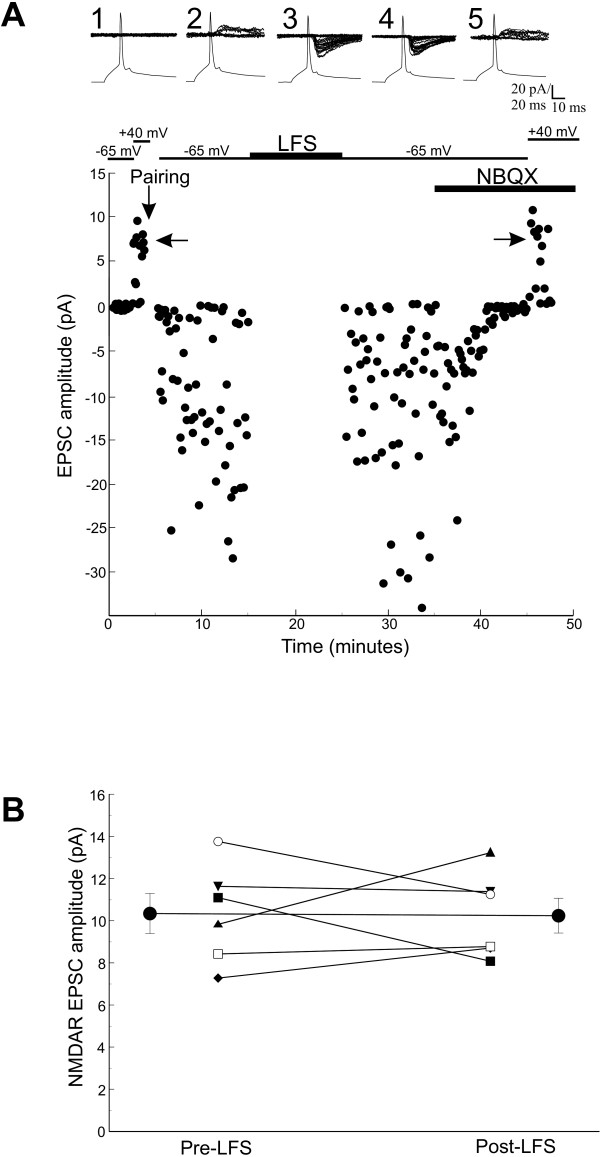
NMDAR-mediated responses are not depressed by LFS in recently unsilenced synapses. A. An individual experiment showing a silent synaptic connection with no AMPAR-mediated transmission at -65 mV. Depolarization of the postsynaptic cell to +40 mV revealed the NMDAR-mediated responses (left arrow). Following the induction of LTP by pairing (downwards arrow; [6]), AMPAR-mediated responses appeared (at -65 mV). LFS was performed 10 minutes after the synapse was potentiated. LFS caused no depression of AMPAR-mediated transmission. Subsequent application of the AMPAR antagonist NBQX (10 μM) and depolarization of the postsynaptic cell to +40 mV revealed the NMDAR-only EPSC (right arrow), which was then compared with the NMDAR EPSC before synapse unsilencing (left arrow). Insets (1–5) show example traces at -65 mV (1) and +40 mV (2) prior to pairing; at -65 mV post-pairing (3), at -65 mV post-LFS (4) and at +40 mV during NBQX application (5). B. Data from six paired recording experiments, each performed as shown in part (A) showing that NMDAR-mediated transmission was unchanged by LFS in recently unsilenced synapses. Offset symbols show the average of the six experiments.